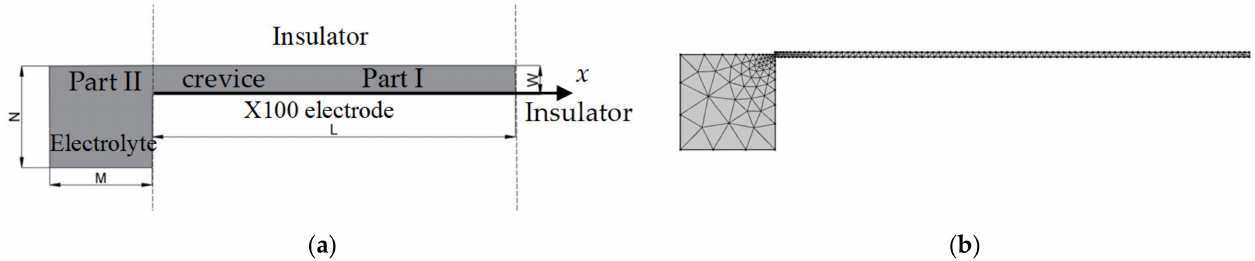
Figure 13. 2D electrochemical model for X100 crevice corrosion: ( a ) the geometric model; ( b ) the meshed